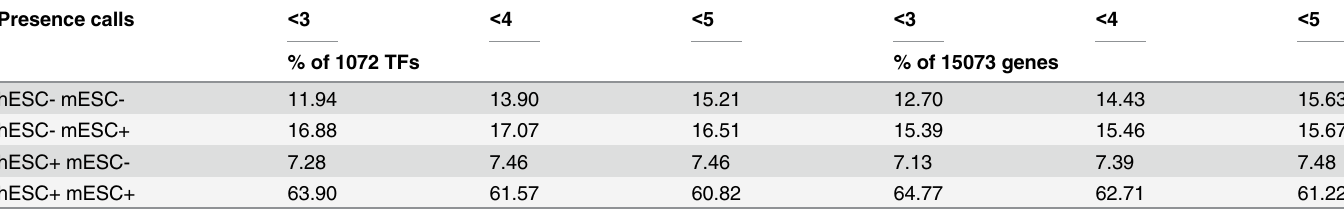
Percentage of orthologous genes and transcriptions factors for different combination of their expression status (+ for expressed and – for not expressed) in human (hESC) and mouse (mESC)